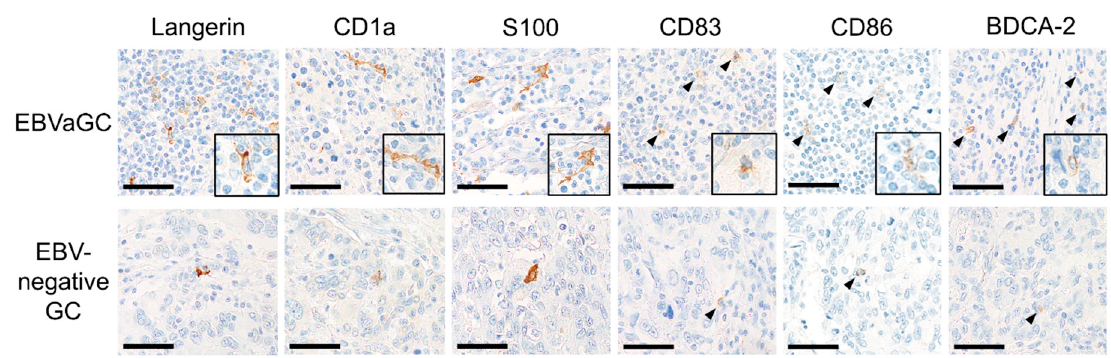
Figure 4. Representative figures of dendritic cells expressing each DC marker in gastric cancer tissue. DCs expressing Langerin, CD1a, and S100 were identified as cells with abundant dendrites. DCs expressing BDCA-2, CD83, and CD86 were identified as relatively small round cells (arrowhead). More abundant infiltration of dendritic cells in EBVaGC was observed than in EBV-negative gastric cancer for each DC marker. Immunohistochemical analysis of Langerin, CD1a, S100, CD83, CD86 and BDCA. Scale bar: 50 µ